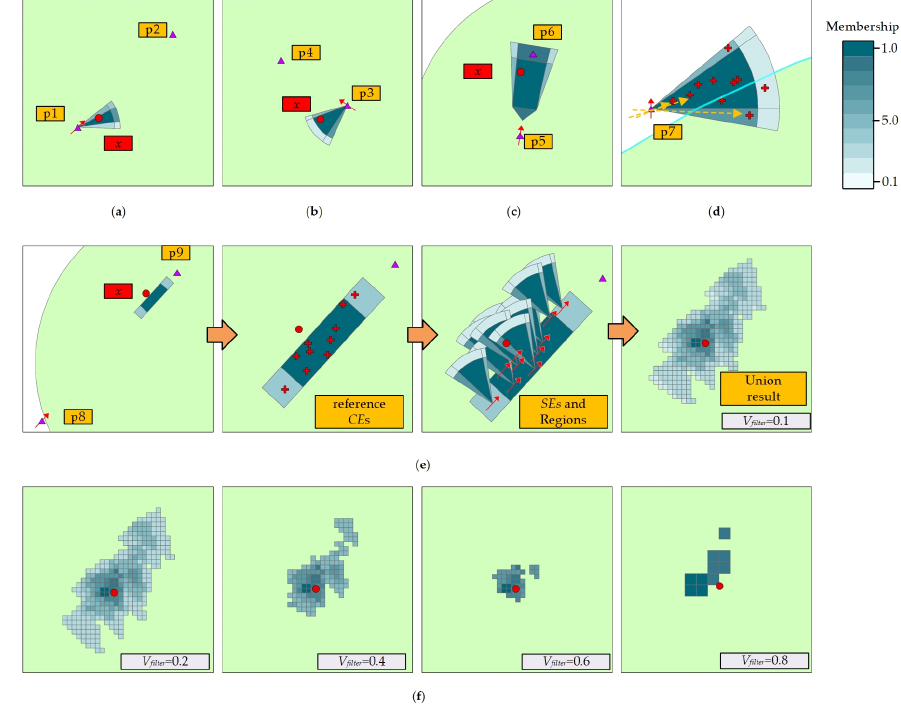
Figure 8. The amplification result of descriptions: ( a ) result of description a; ( b ) result of description b; ( c ) description c; ( d ) action result of description d; ( e ) detail result of description e; ( f ) the influence of V filter .